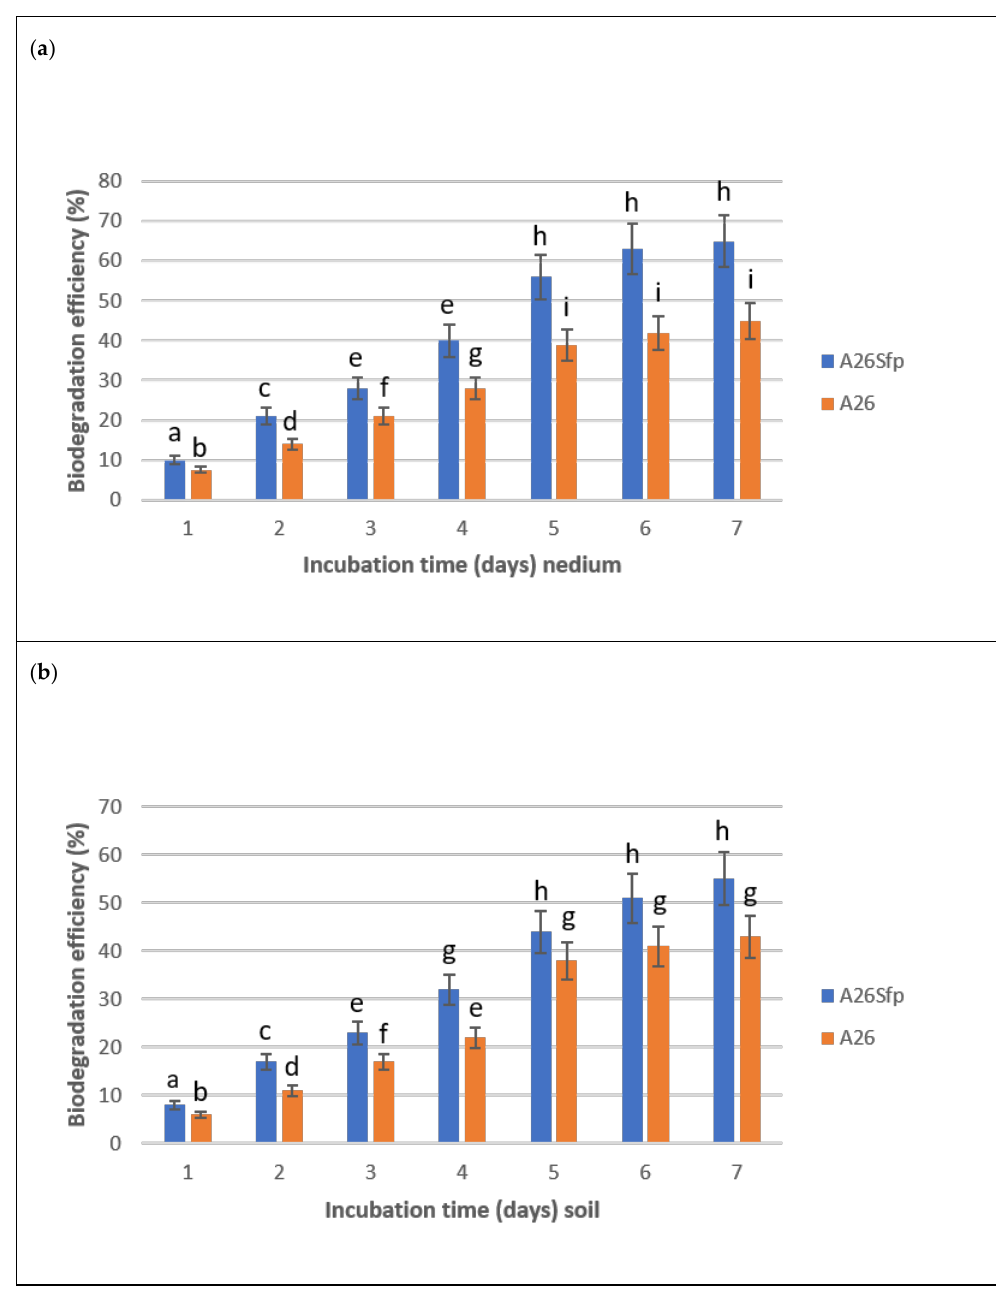
Figure 1. Growth (optical density at 600 nm) of Paenibacillus polymyxa A26 and P. polymyxa A26Sfp in mineral medium containing naphthalene (100 mg/L). Different letters indicate statistically significant differences; see Material and Methods.